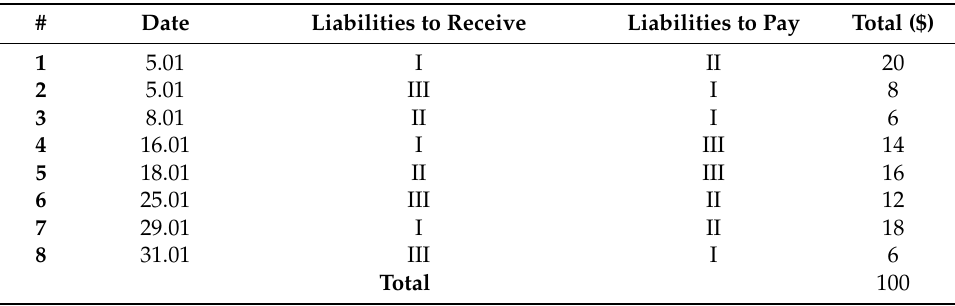
Table 1. The journal of operations (Ledger) of players I, II, III